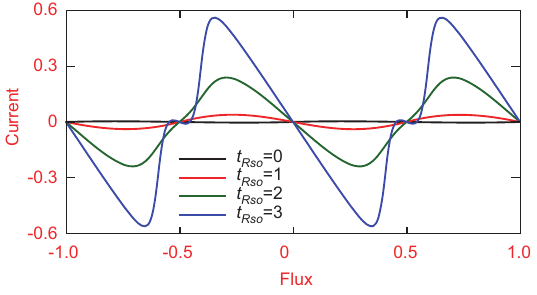
Figure 21 Current-fl ux characteristics of an 80-site disordered ( W = 2) half-fi lled ring for different values of t at 0.